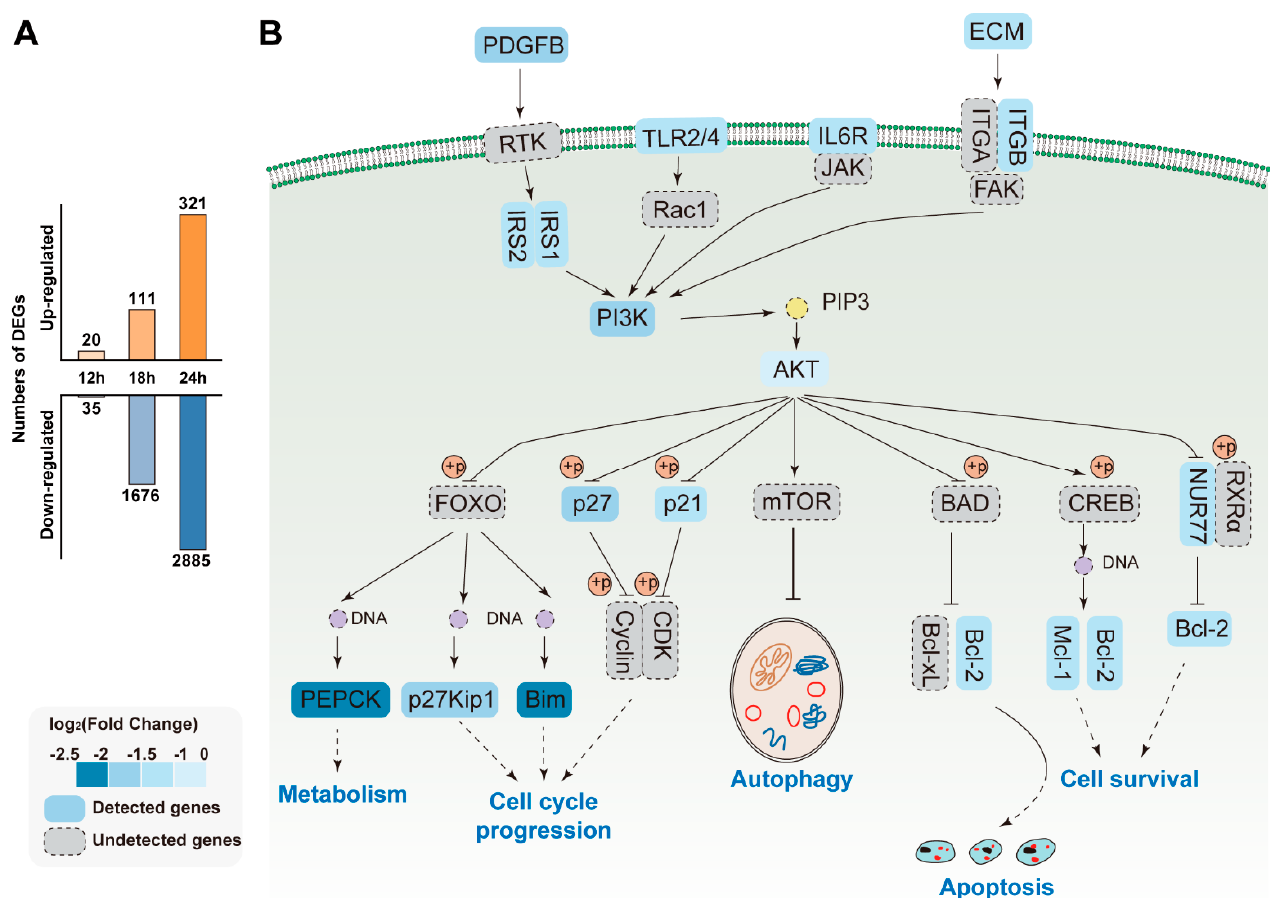
Figure 8. Signaling pathways affected by SADS-CoV infection. ( A ) Barplot of DEGs number in SADS-CoV infection cells at three time-points. ( B ) Schematic representation of the signaling pathways that converge on autophagy, apoptosis, cell cycle progression, and metabolism. The proteins detected in SADS-CoV-infected cells are shown in the solid boxes, whereas the proteins that remained undetected in our study are shown in the dotted boxes. Boxes in different shades of color represent proteins fold change.